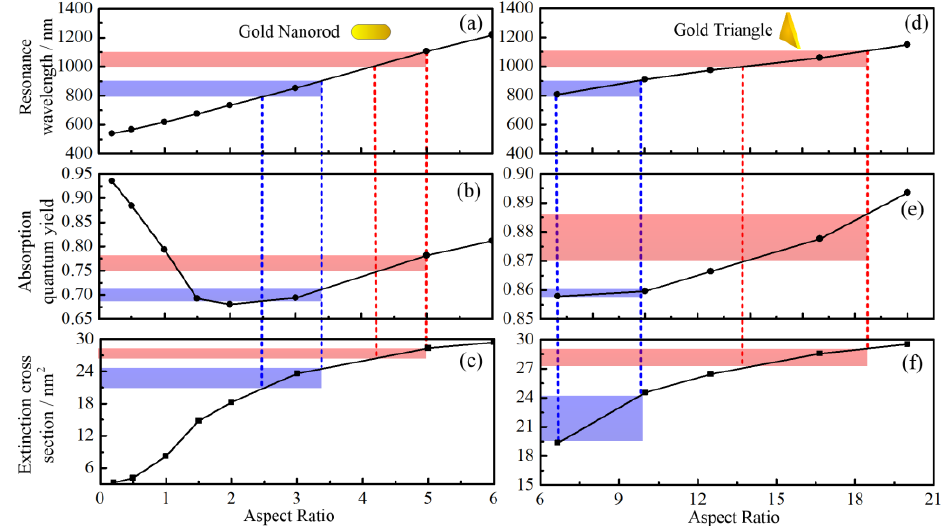
Figure 1. Correlation between resonance wavelength, absorption quantum yield, and extinction cross section with the aspect ratio, respectively. ( a – c ) nanorod; ( d – f ) nanotriangle. The color bars indicate the results corresponding to commonly used laser wavelengthes.